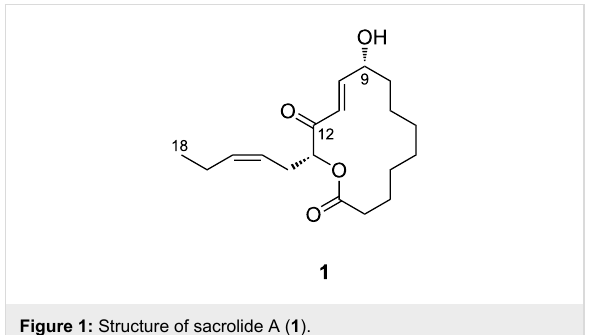
Figure 1: Structure of sacrolide A ( 1